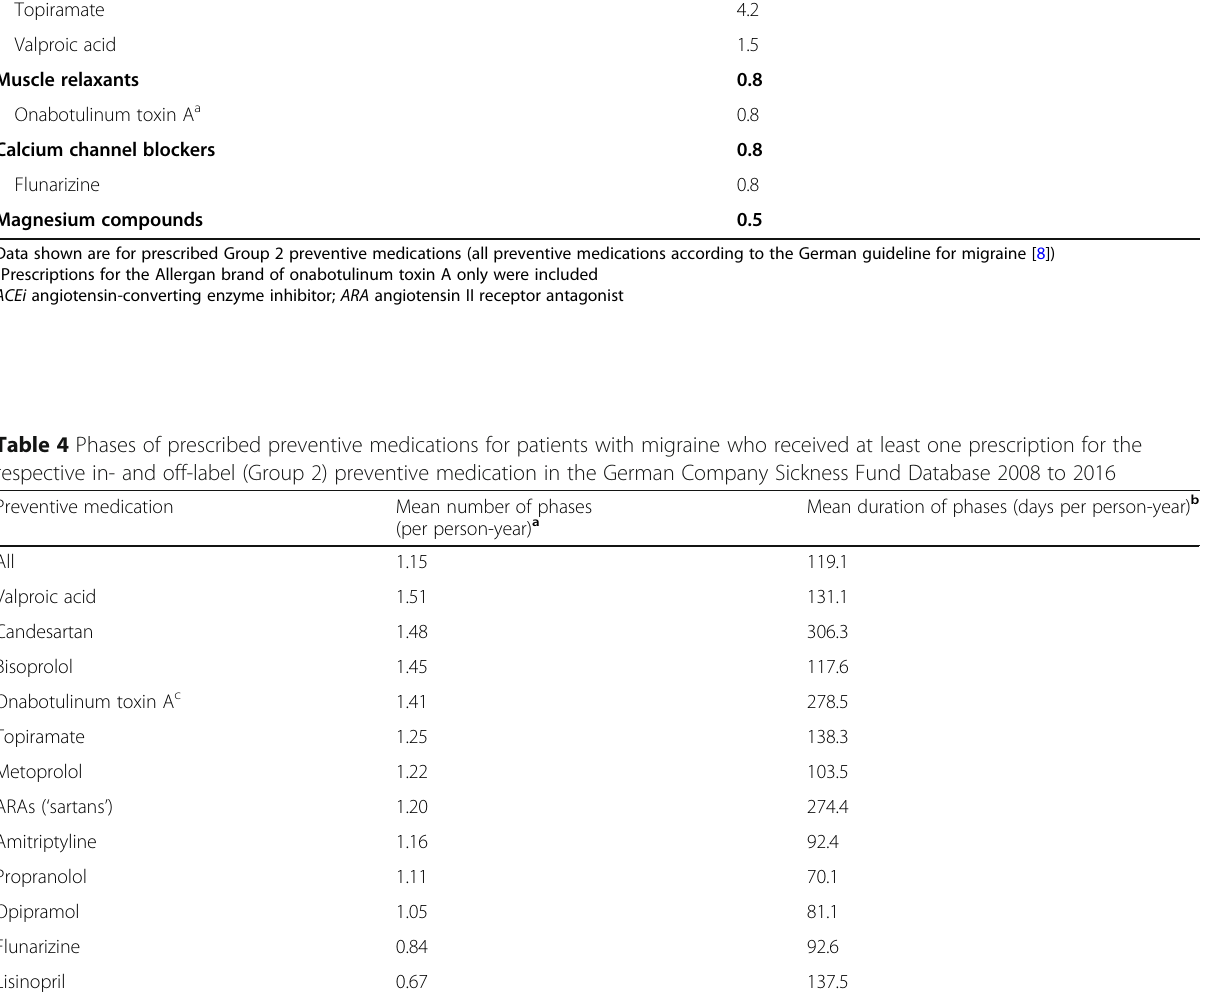
ARA angiotensin II receptor